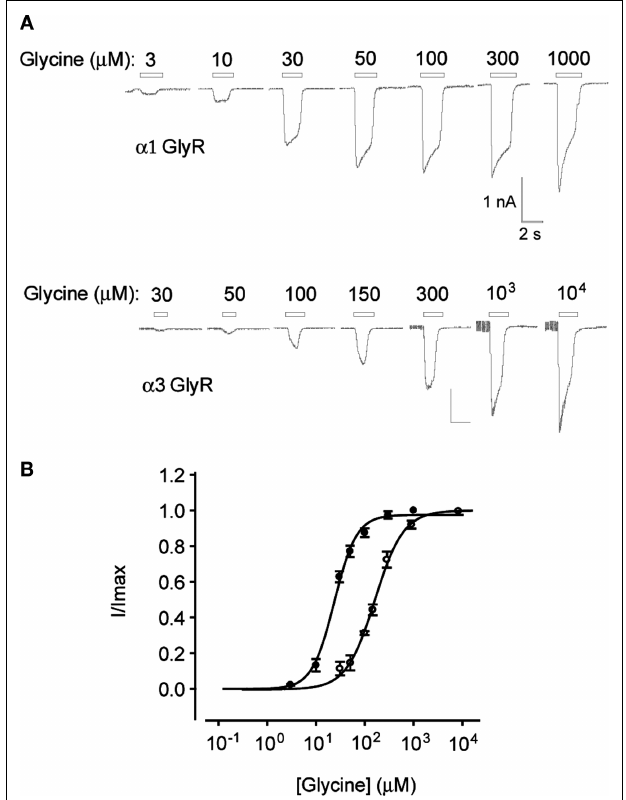
FIGURE 2 | Planar whole-cell patch-clamp data from HEK293 cells stably expressing α 1 or α 3 GlyRs. (A) Current responses in cells expressing α 1 and α 3 GlyRs. Indicated glycine concentrations were applied for 2 s at 1 min intervals. (B) Averaged glycine dose–responses averaged from fi ve cells expressing either α 1 (fi lled symbols) or α 3 GlyRs (unfi lled symbols). Error bars represent standard errors and curves are Hill equation fi ts to the averaged data. Individual α 1 GlyR dose–response curves were fi tted a mean glycine concentration of 24 ± 2 µM and a Hill coeffi cient of 1.9 ± 0.2 ( n = 5 cells). Both values were not signifi cantly different to their respective means (30 ± 1 µM and 1.7 ± 0.2, n = 5) recorded by conventional patch-clamp of HEK293 cells transiently expressing α 1 GlyRs (Chen et al., 2009a). The α 3 GlyR dose– responses were fi tted with a mean glycine concentration of 166 ± 9 µM and a Hill coeffi cient of 1.4 ± 0.1 ( n = 5 cells). In contrast, the respective mean values for α 3 GlyRs recorded by patch-clamp of transiently transfected HEK293 cells were 309 ± 20 µM and 2.0 ± 0.1 ( n = 5) (Chen et al.,